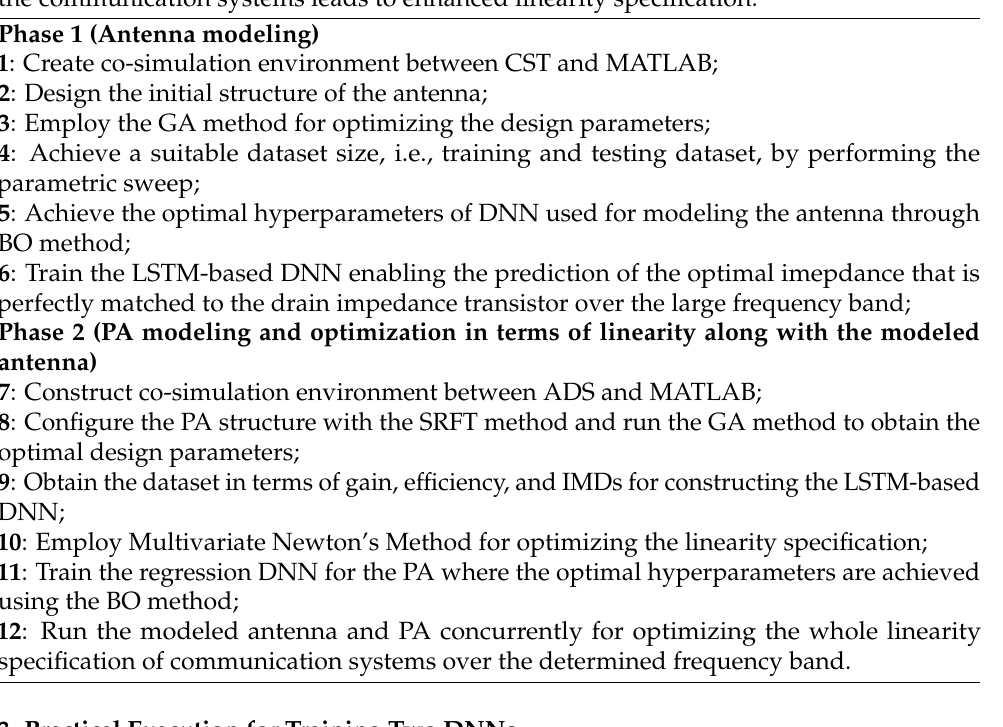
Algorithm 1 Proposed methodology for concurrently modeling antenna and amplifiers in the communication systems leads to enhanced linearity